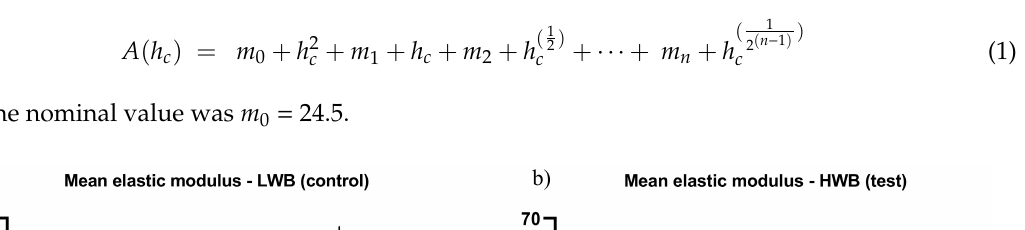
Table 4. Elastic modulus and hardness of high weight bearing (HWB) and low weight bearing (LWB) articular cartilage adjusted to patients’ ages.